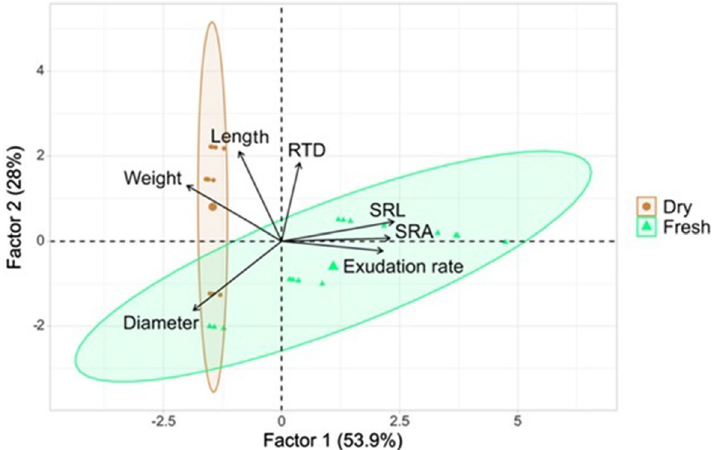
Figure 4. Principal component analysis (PCA) biplot of variables (root tissue density (RTD), specific root area (SRA) and specific root length (SRL), exudation rate – mg C g -1 day -1